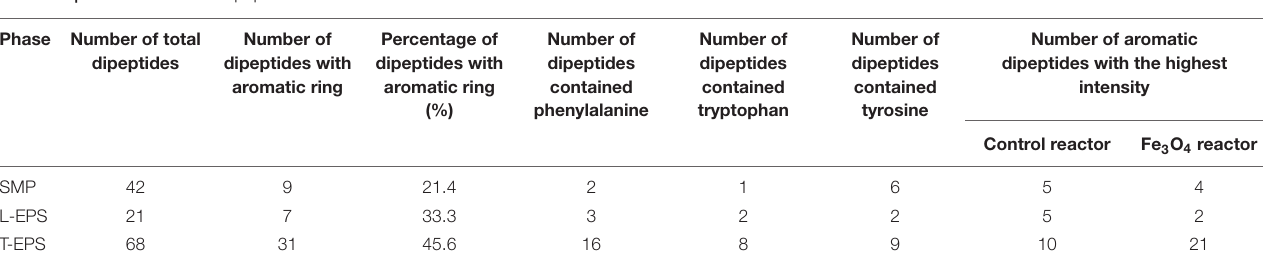
TABLE 2 | Detected result of dipeptides in SMP and